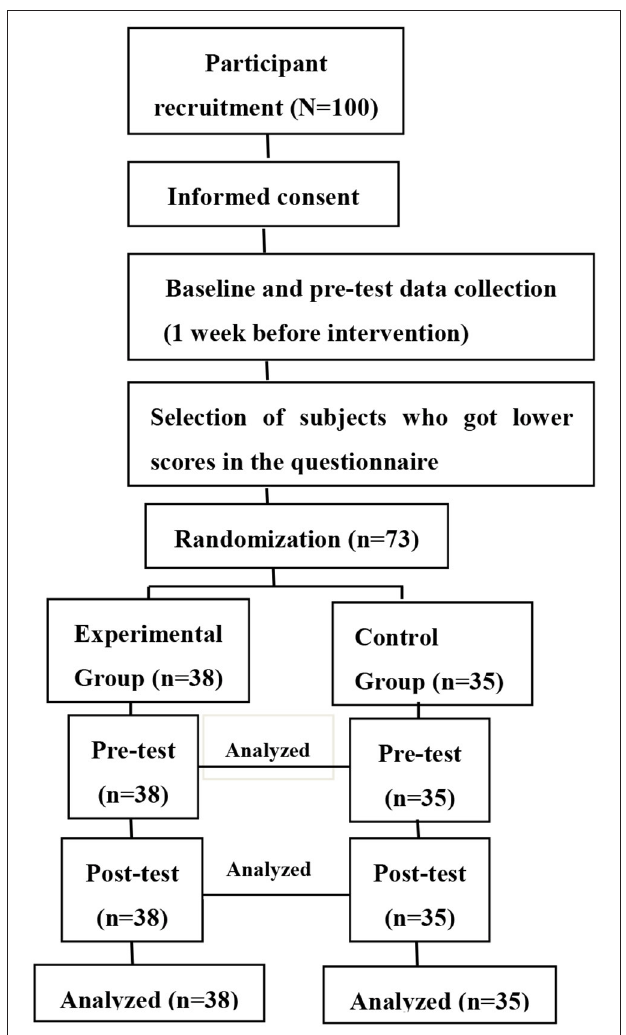
FIGURE 1 | Flow of the experimental study with a randomized pre-post controlled